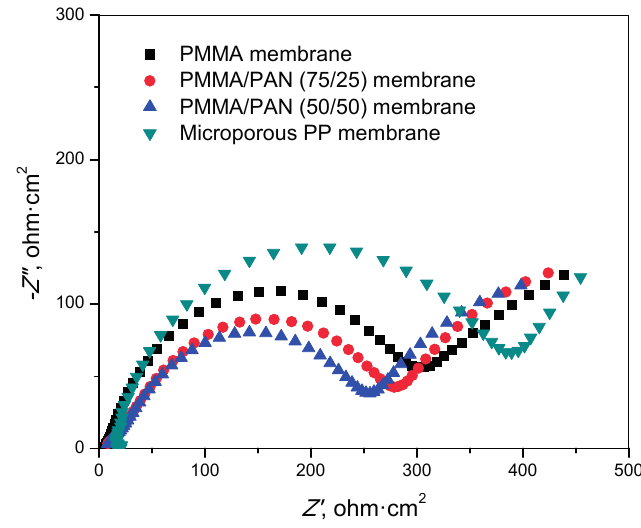
Figure 4. Electrochemical impedance spectra of PMMA membrane, PMMA/PAN (75/25) membrane, PMMA/PAN (50/50) membrane, and microporous PP membrane.